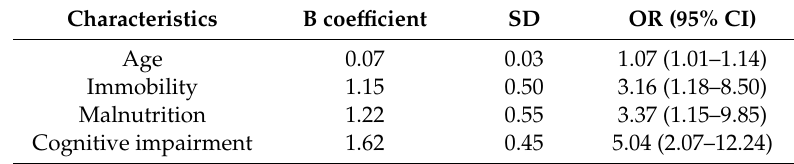
Table 4. Multivariable analysis on factors associated with delirium in the